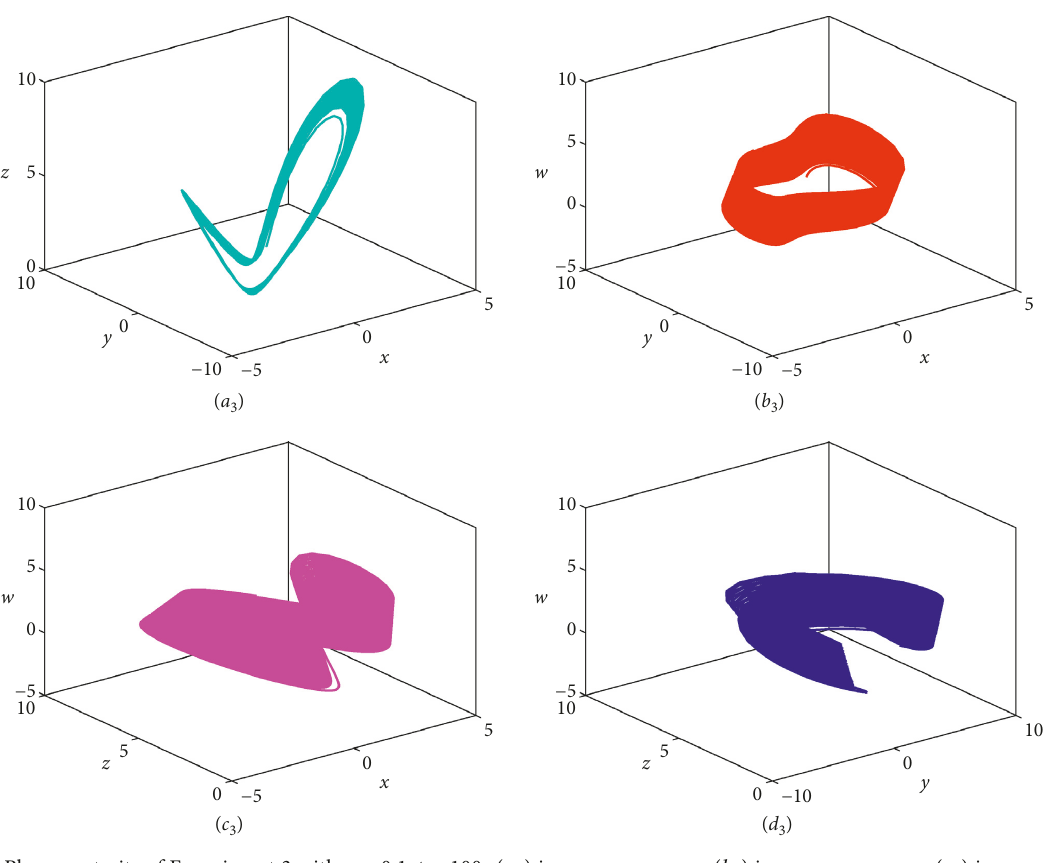
) in x − y − z space; ( b 3